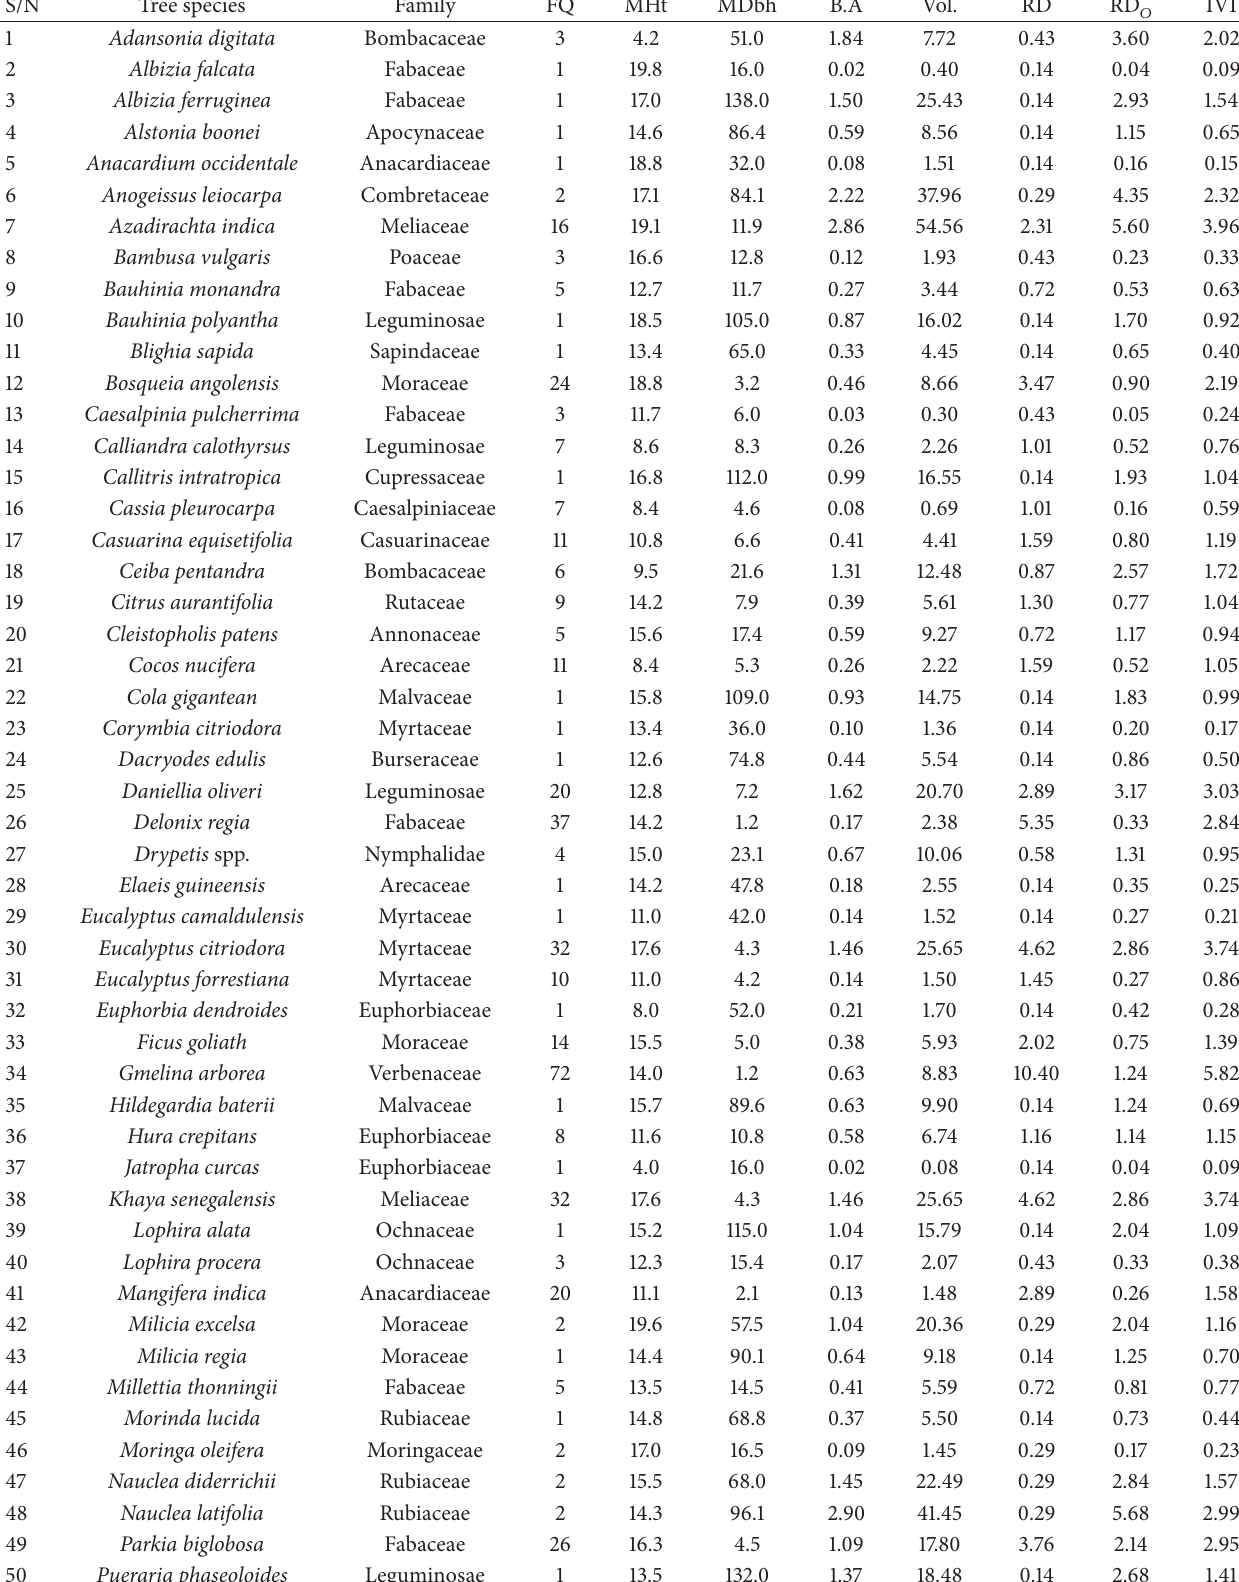
Table 2: Biodiversity indices and growth parameters of individual trees in the urban areas (Abuja city) of the Federal Capital Territory,